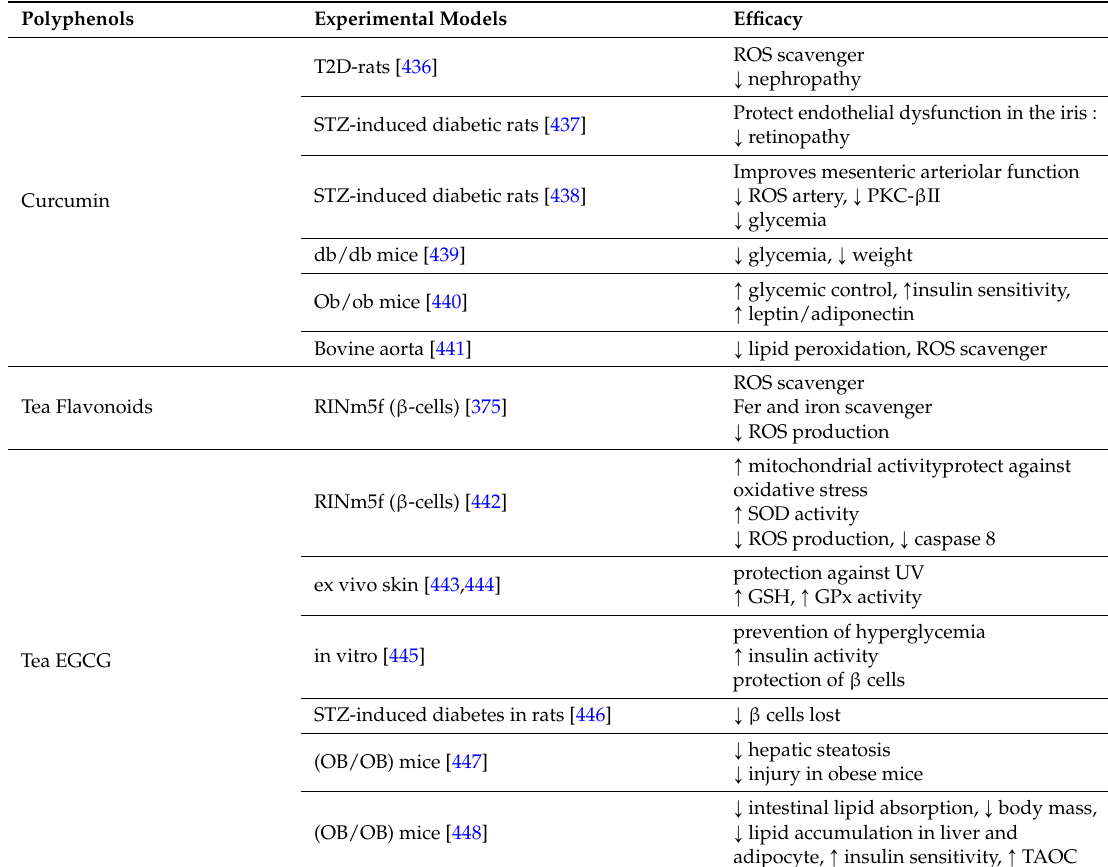
Table 7. Beneficial effects of several polyphenol-rich natural sources on in vitro and in vivo models of